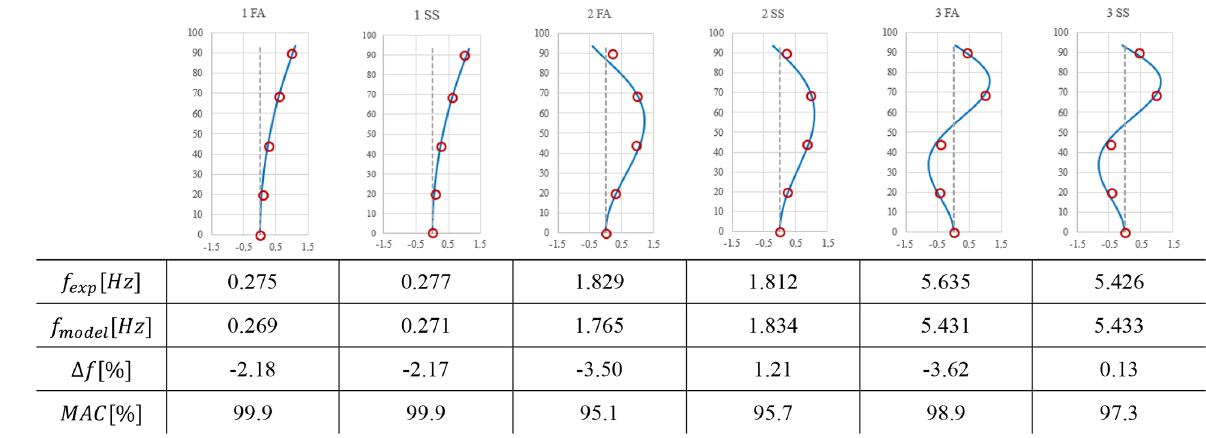
Figure 5. Mode shapes and natural frequencies identified with the ambient-vibration test and numerical model of wind turbine 1.